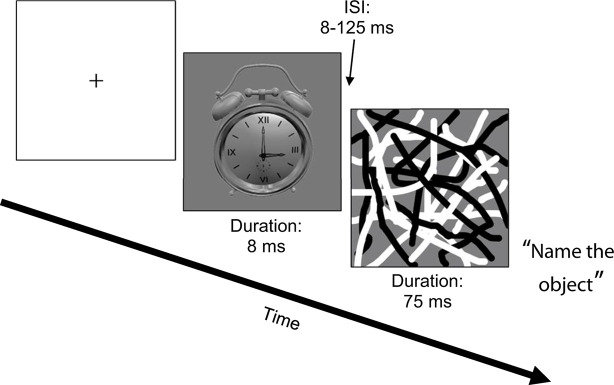
Object Masking task.